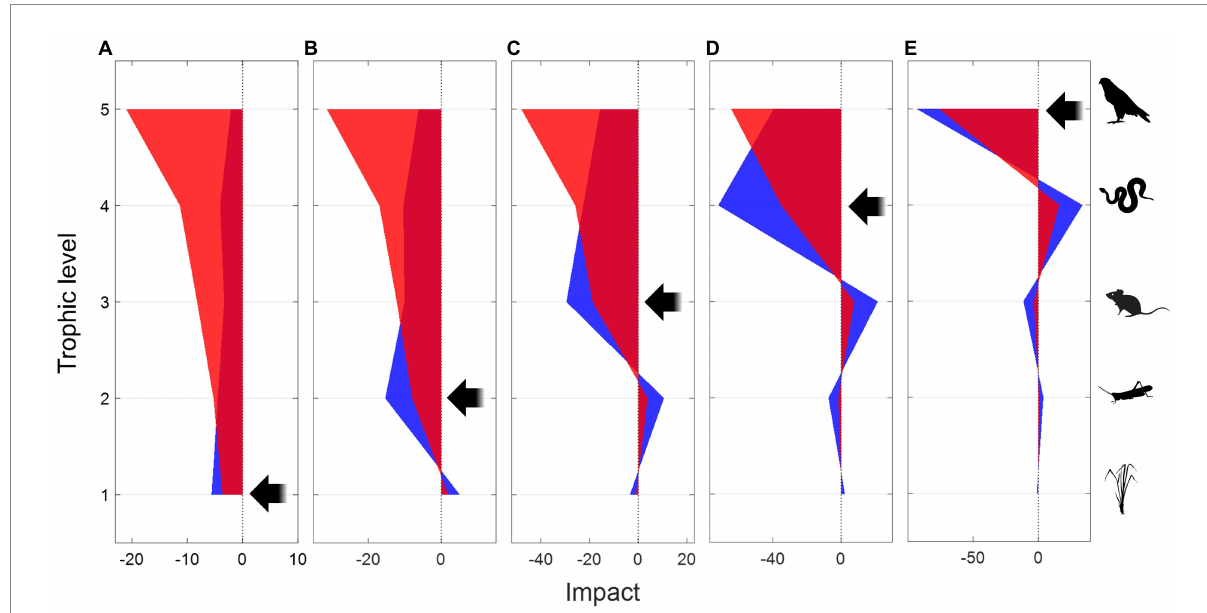
FIGURE 4 Trophic cascades resulting from negative press perturbations on a targeted trophic level, based on the mean values from 10 6 random parameter combinations using Generalized Modeling of a five-species food chain. The impact (x-axis) measures the relative rate of change in equilibrium population sizes per unit change in the targeted species’ population growth rate. Negative (or positive) impacts indicate declining (or increasing) equilibrium population size. Black arrows indicate the direction of perturbation and the targeted trophic level (y-axis), from producers (A) to the top predator (E) . Blue areas represent scenarios without metabolic responses, and the overlaid semi-transparent red areas represent scenarios with negative metabolic